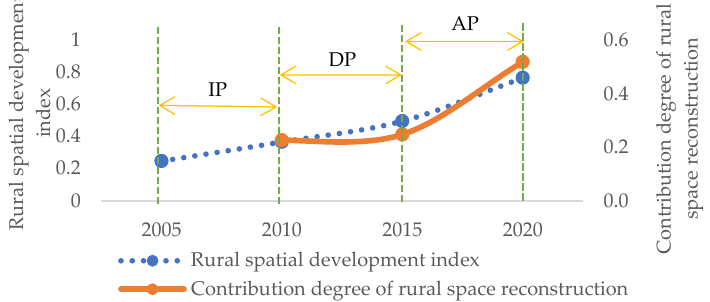
Figure 4. Phases of rural space reconstruction in East Tumen Village and West Tumen Village.